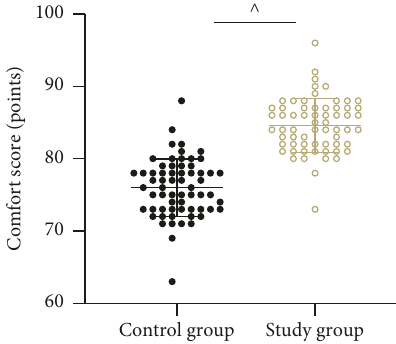
Figure 2: Comparison of the postoperative comfort score within the two groups (points). ^ represents a significant difference be- tween the two groups.